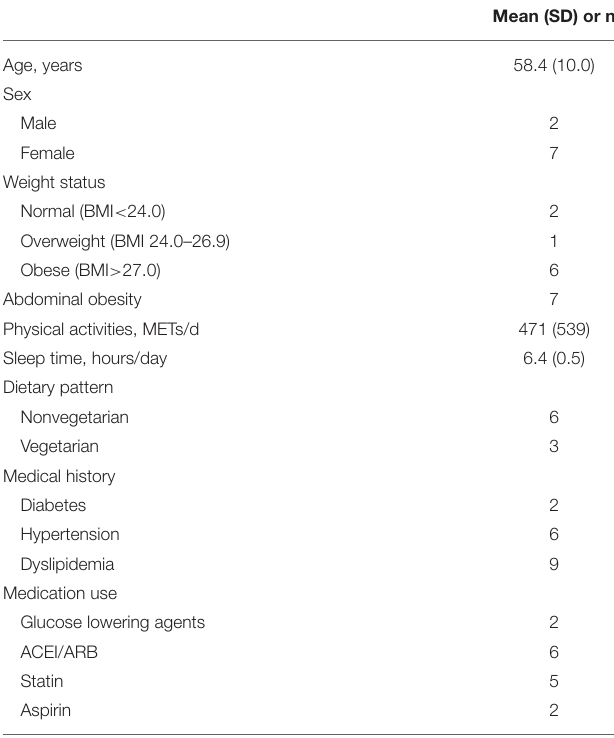
TABLE 2 | Baseline characteristics of nine study participants.